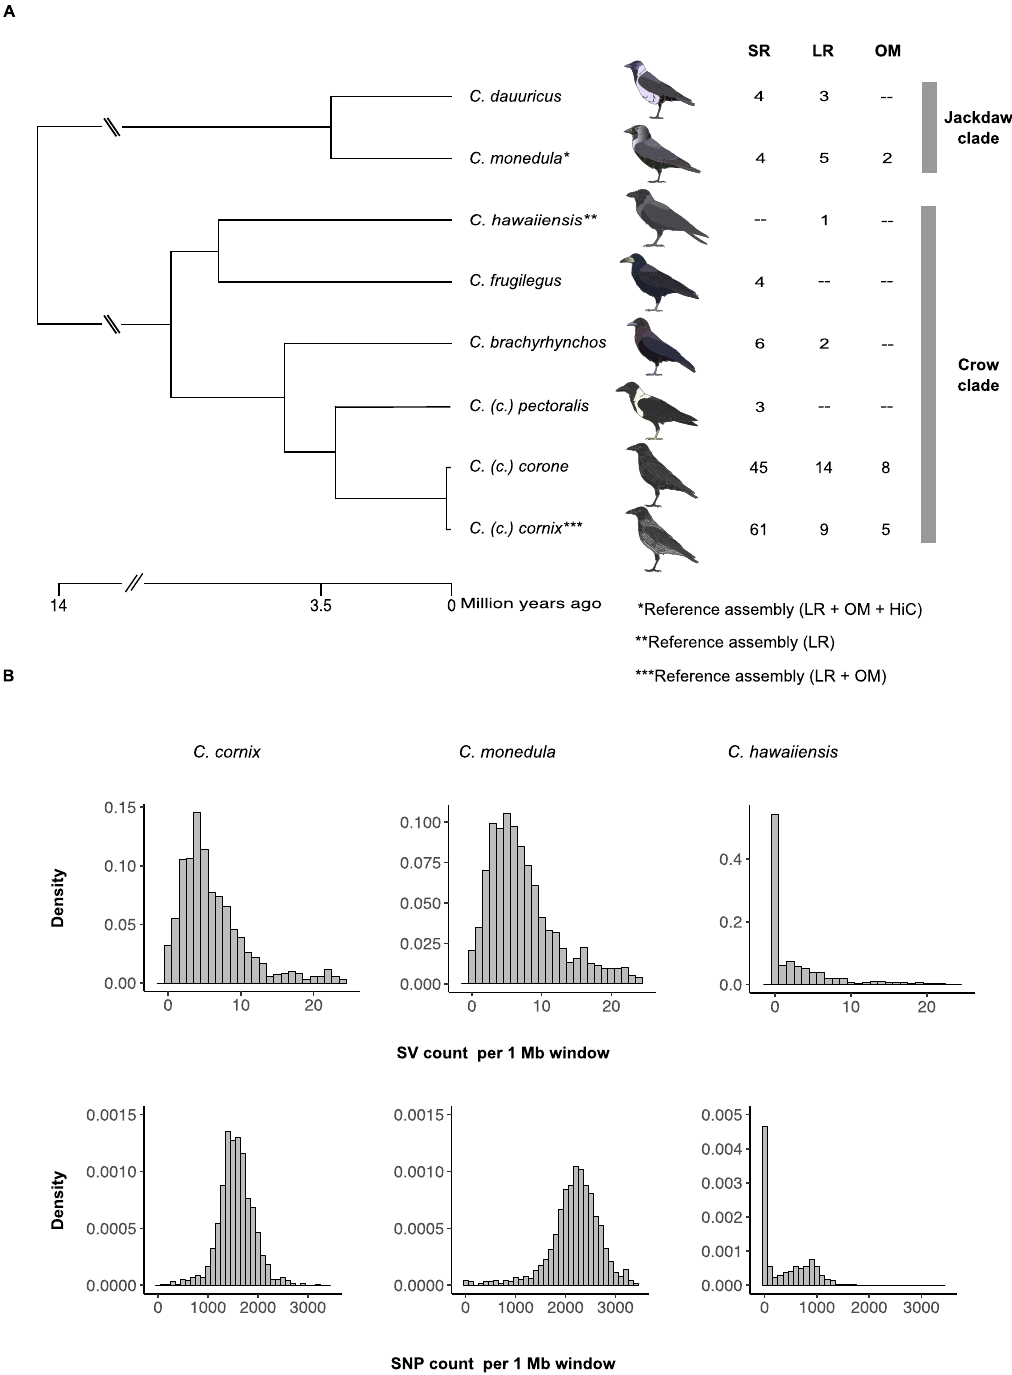
Fig. 1 Sampling setup and assembly-based structural and single-nucleotide variation. a Phylogeny of sampled species in the genus Corvus (after, see ref. 18 ). Numbers in columns represent individual numbers for short-read sequencing (SR), long-read sequencing (LR), and optical mapping (OM). b Density histogram showing the abundance of genetic variation within single individuals. Counts of variants per 1 Mb windows are based on comparing the two haplotypes of each assembly. The upper panel re fl ects structural variation (SV) densities, the lower panel re fl ects densities for SNPs. Crow drawings